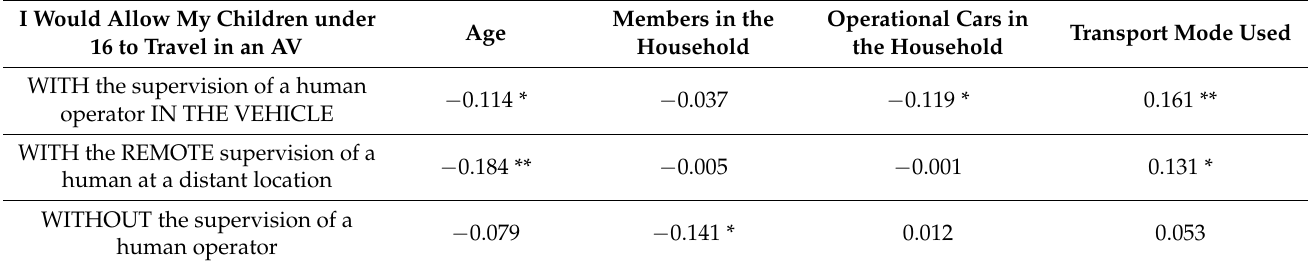
Table 7. Spearman correlation between socio-economic characteristics of the sample and potential use of AVs by children under 16 (Source: Authors’ survey